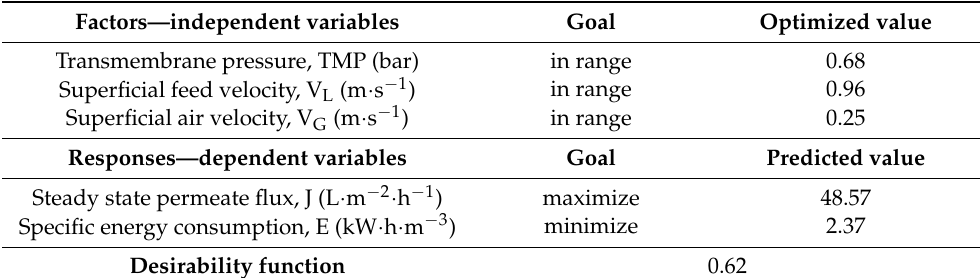
Table 4. Optimization results obtained by the desirability function approach during microfiltration of Bacillus velezensis IP22 cultivation broth aided with air